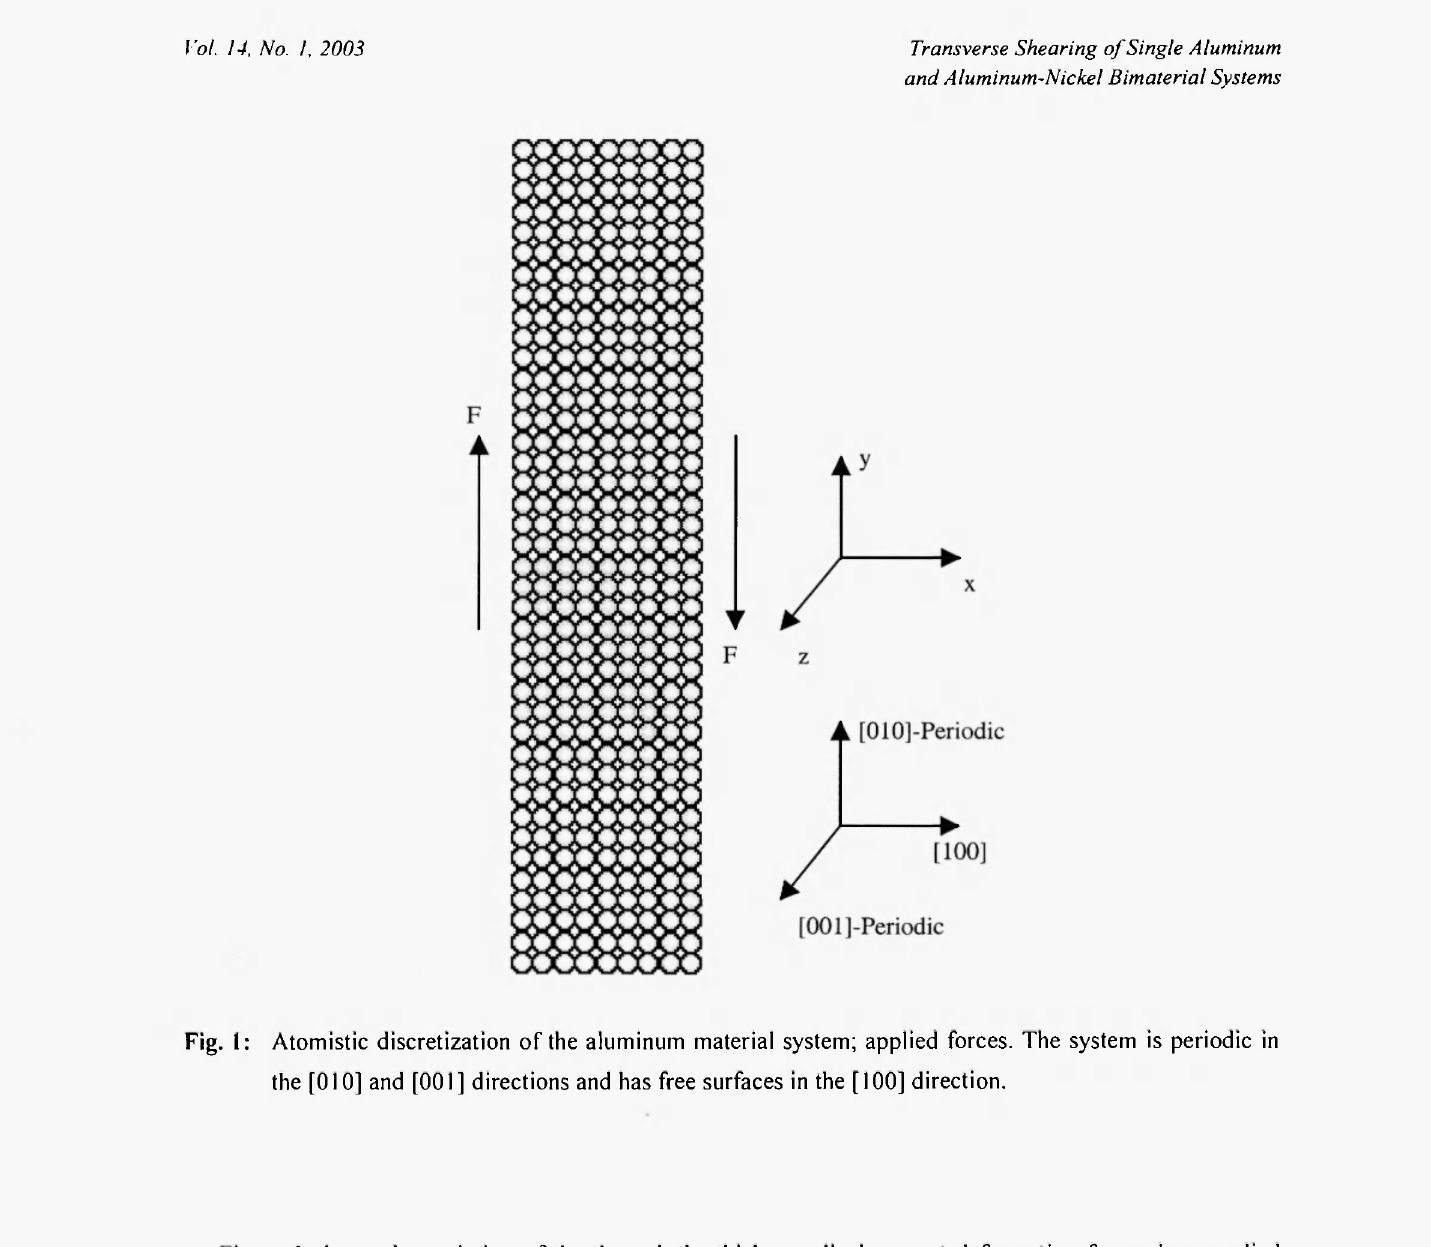
Fig. 1: Atomistic discretization of the aluminum material system; applied forces. The system is periodic in the [010] and [001] directions and has free surfaces in the [100]